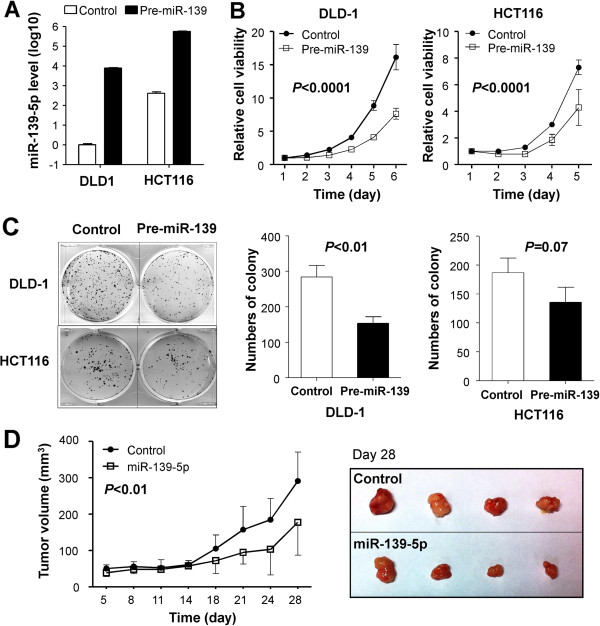
miR-139-5p inhibited colon cancer cell growth in vitro and in vivo. (A) Ectopic expression of miR-139-5p in colon cancer cell lines DLD1 and HCT116 were evidence by qRT-PCR after transfection of pre-miR-139. (B) miR-139-5p significantly inhibited DLD1 and HCT116 cell viability. Cell growth rates were detected by MTS assay. (C) miR-139-5p inhibited DLD1 and HCT116 cells colony formation (left panel). Quantitative analysis of DLD1 and HCT116 colony numbers (n = 3, mean ± SD) (right panel). (D) miR-139-5p inhibited colon cancer cell growth in vivo. Tumor growth curve of pre-miR-139-5p and control transfected HCT116 cells in nude mice. Data are mean ± SD (n = 4/group) (left panel). Images of the tumors induced by pre-miR-139-5p or control were shown (right panel).